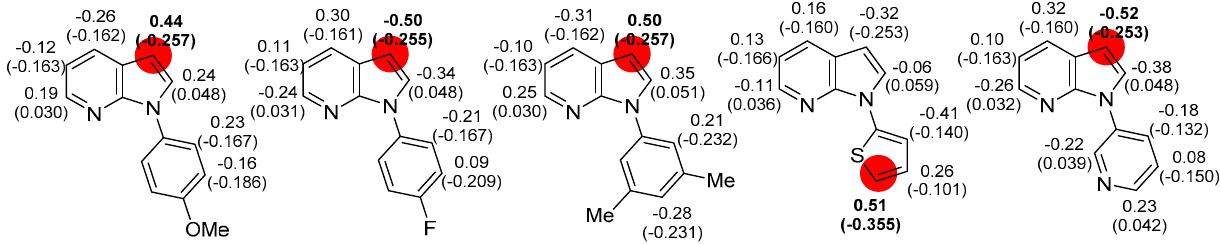
Figure 10. Calculated C charges (in brackets) and HOMO coefficients (obtained by using the HuLiS calculator [73]) for 1- (4-methoxyphenyl)-7-azaindole ( 1b ), 1-(4-fluorophenyl)-7-azaindole ( 1d ), 1-(3,5-dimethylphenyl)-7-azaindole ( 1f ), 1-(2- thienyl)-7-azaindole ( 1g ) and 1-(3-pyridyl)-7-azaindole ( 1h ).